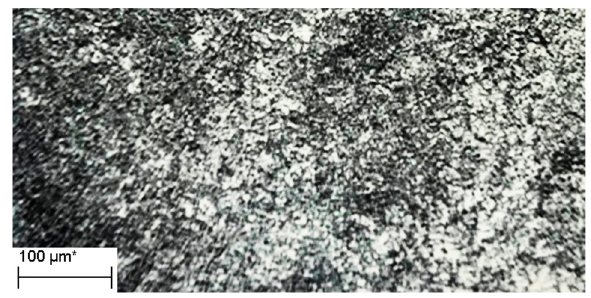
Figure 11. Structure of the overheating section, template 2 (Figure 7). ×400. *—mkm.